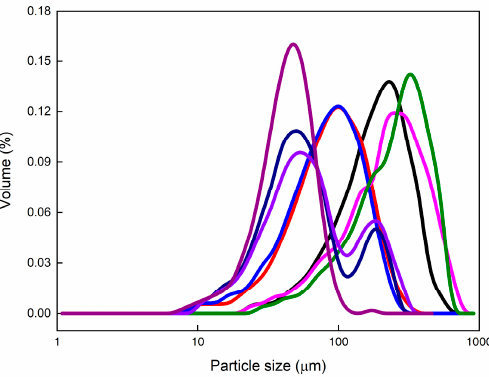
Figure 6. Particle size distribution for experiments LC-1 — , LC-2 — , LC3 — , DNC-1 — , DNC-2 — , IMDNC-1 — , IMDNC-2 — , EMDNC — .